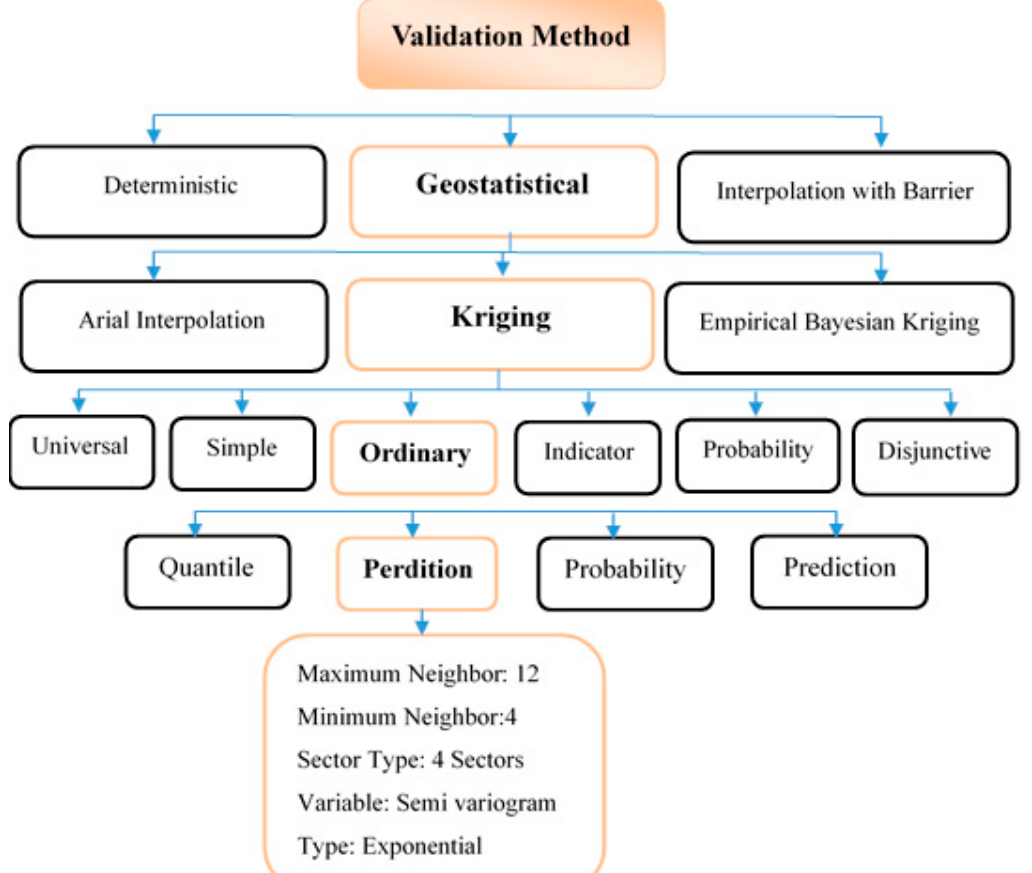
Figure 4. Flow of the Research Work. Appl. Sci. 2020 , 10 , x FOR PEER REVIEW